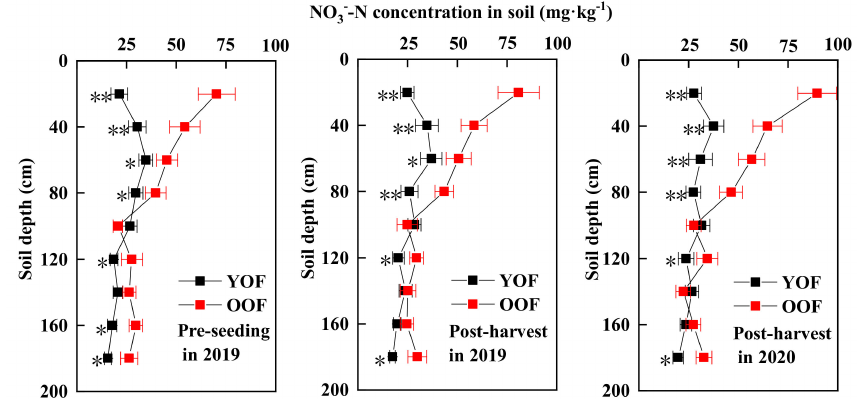
Figure 7. Soil NO 3 − − N in the 0 − 200 cm soil profile. Error bars represent standard deviation. ** and * represent p < 0.01 and p < 0.05 between the young oasis field (YOF) and old oasis field (OOF) at the same depth, respectively.